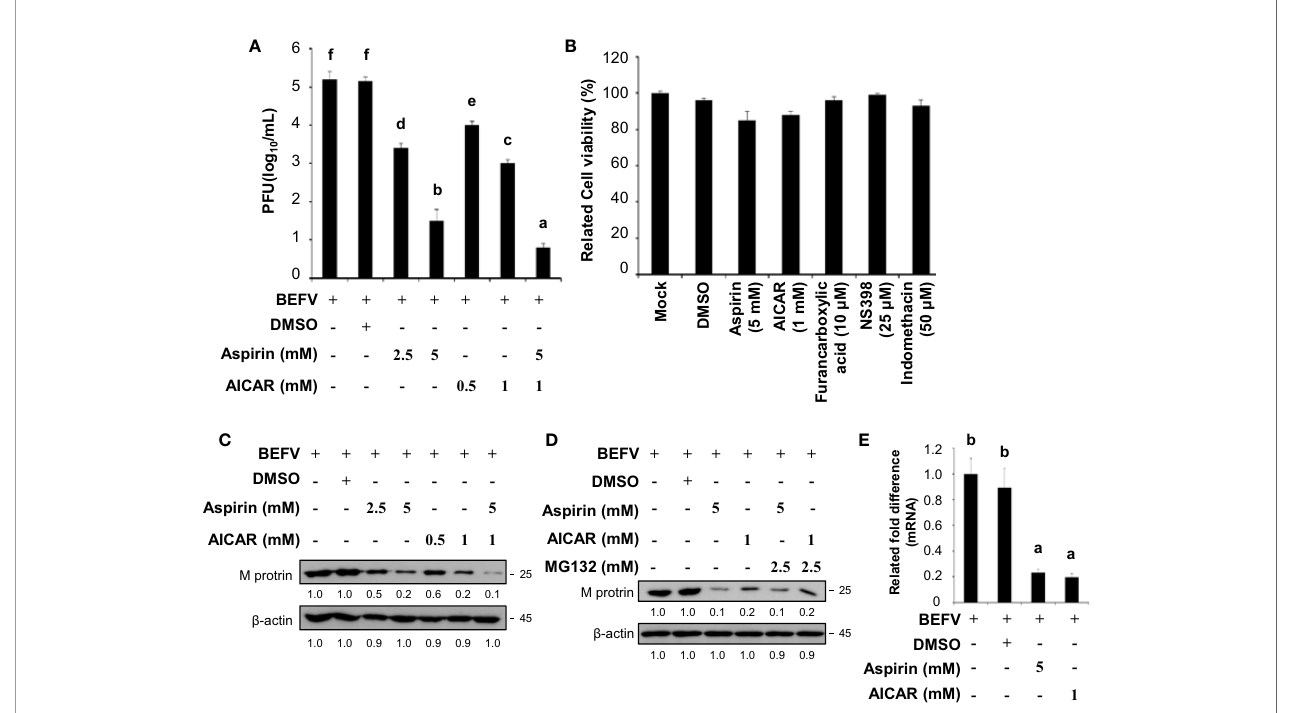
FIGURE 1 | Aspirin and 5-aminoimidazole-4-carboxamide-1- b -riboside (AICAR) inhibit viral growth. (A) Madin-Darby bovine kidney (MDBK) cells were pretreated with or without aspirin (2.5 and 5 mM) or AICAR (0.5 and 1 mM), respectively, for 30 min and then infected with BEFV at an MOI of 1 for 18 h. The effect of aspirin and AICAR on BEFV production was determined. Signi fi cance between the treatments was determined by Duncan ’ s Multiple Range Test (MDRT) using SPSS software (Version 20.0). Means with common alphabets (a, b, c, d,e, f) denotes no signi fi cance at p <0.05. Each value represents mean ± SE of three independent experiments. (B) To examine whether the compounds used in this study had the deleterious effects on cells, cell viability was determined using the MTT assay. Each value represents mean ± SE of three independent experiments. (C, D) The levels of the BEFV M protein in aspirin- and AICAR-treated MDBK cells were examined (C) in the presence or absence of proteasome inhibitor MG132 (D) . The levels of indicated proteins in the BEFV-infected group were considered onefold. The inactivation folds indicated below each lane were normalized against values for the BEFV-infected group. Protein levels were normalized to those for b ‐ actin. Signals in all Western blots were quanti fi ed with ImageJ software. All experiments were conducted in three independent experiments. (E) The BEFV M and GADPH mRNA levels were quanti fi ed by real-time qRT-PCR in BEFV-infected MDBK cells in the presence or absence of indicated drugs. In real-time qRT-PCR ampli fi cation of the M and GADPH genes, MDBK cells were infected with BEFV at an MOI of 1. The BEFV-infected cells were collected at either 24 hpi, and total RNAs were extracted for real-time qRT-PCR. Signi fi cance between the treatments was determined by Duncan ’ s Multiple Range Test (MDRT) using SPSS software (Version 20.0). Means with common alphabets (a, b) denotes no signi fi cance at p <0.05. Each value represents mean ± SE of three independent